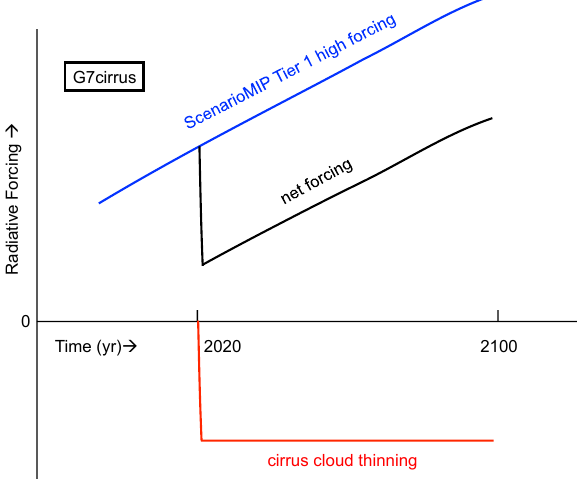
Figure 3. Test simulations of reducing cirrus cloud optical depth ( τ ) as described in Sect. 2.4. τ were scaled by a factor of ε < 1 ( x axis). The amount of surface air temperature change due to this scaling ( y axis) was measured over a 4-year average; 0 indicates the global mean surface air temperature over years 2020–2023 in an RCP8.5 simulation. All simulations were performed using GISS ModelE2 (Schmidt et al.,